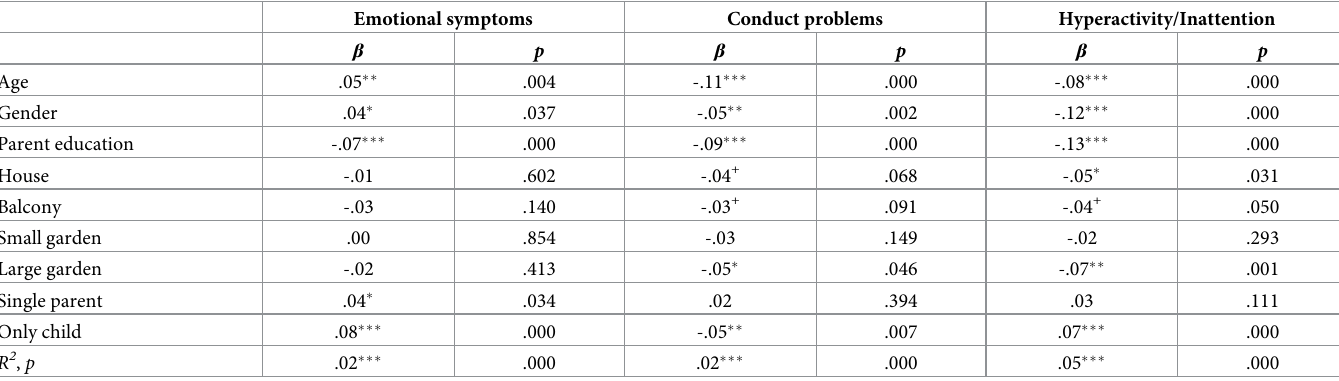
Table 2. Linear regressions on children’s problem behavior.